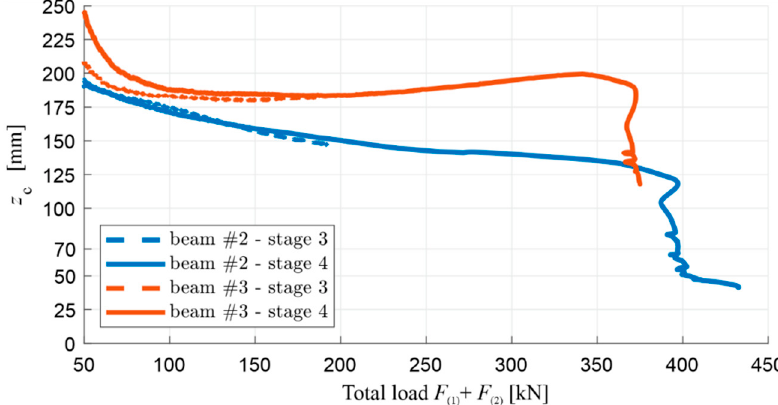
Figure 26. Diagram of the position of the neutral axis as its distance from the compression face of beams #2 and #3 at the middle of the span in the function of the total load in stages 3 and 4 during the increasing of the load.